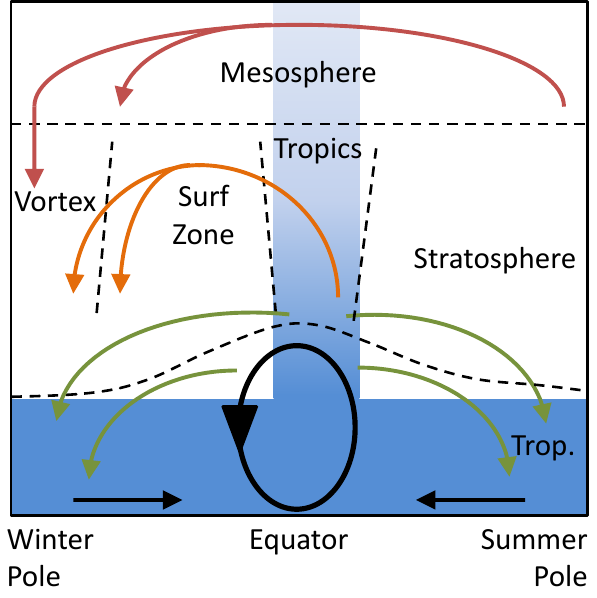
Fig. 1. Conceptual structure of the Brewer–Dobson circula- tion (BDC) following Plumb (2002). The three main circulation branches are highlighted in different colours, which are used in summary Fig. 12 to distinguish the height regions. Blue shadings indicate the general altitude gradient of N 2 O with near-constant N 2 O in the troposphere (Trop.). The complex meridional N 2 O gra- dient structure in the stratosphere is shaped by the different BDC branches and is not detailed